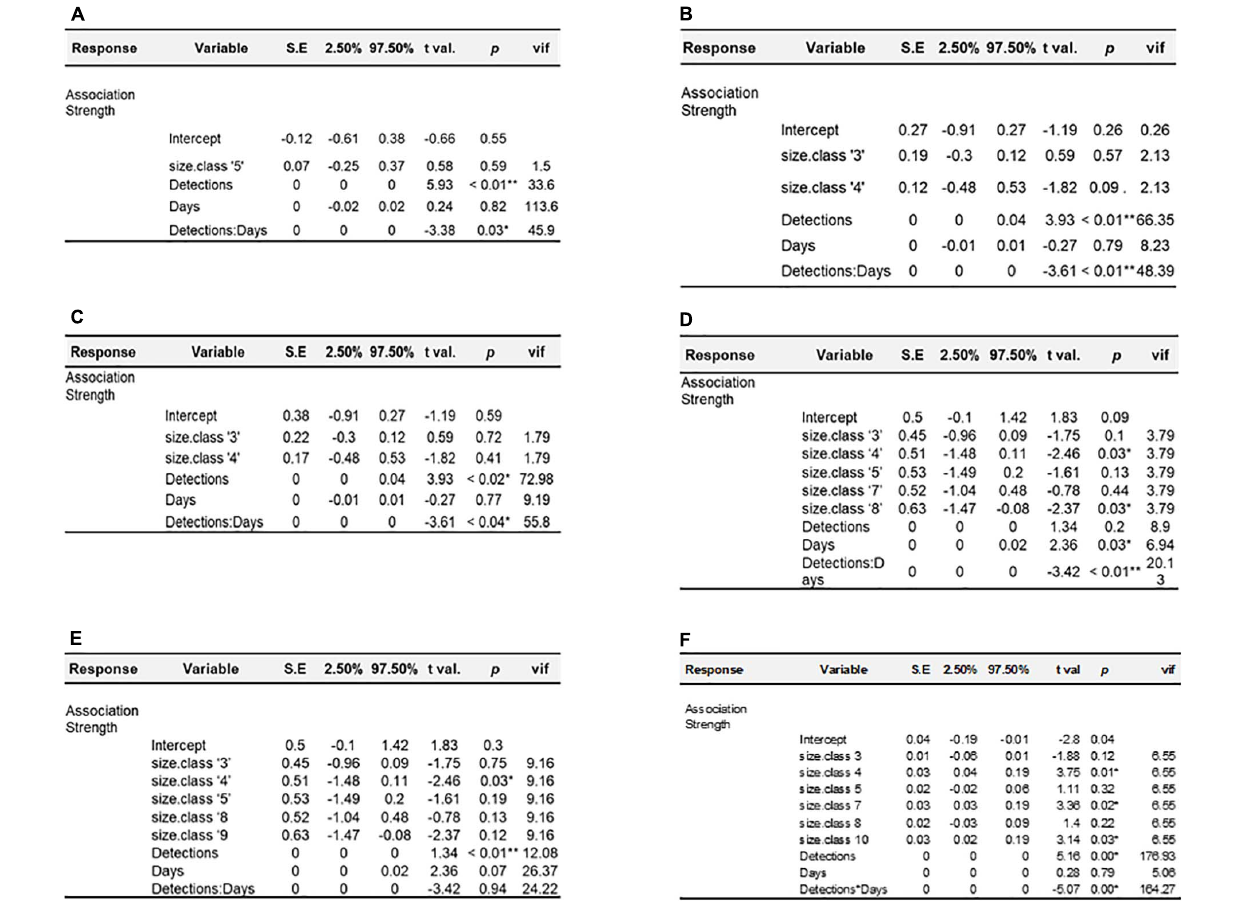
FIGURE 5 | Results of multiple linear regression analyses. Each panel shows model results for the corresponding year; (A) 2014, (B) 2015, (C) 2016, (D) 2017, (E) 2018, (F) 2019.